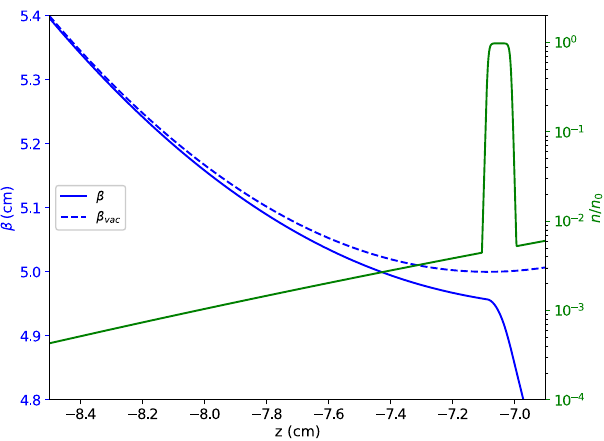
FIG. 3. Evolution of the electron beam beta function in the region of the plasma lens. Perturbative focusing from the low density plasma ramp shifts the beta function (solid blue) away from its theoretical vacuum trajectory (dashed blue). The plasma density profile n p is given in logarithmic scale by the solid green line, where n 0 ¼ 3 × 10 16 cm − 3 .